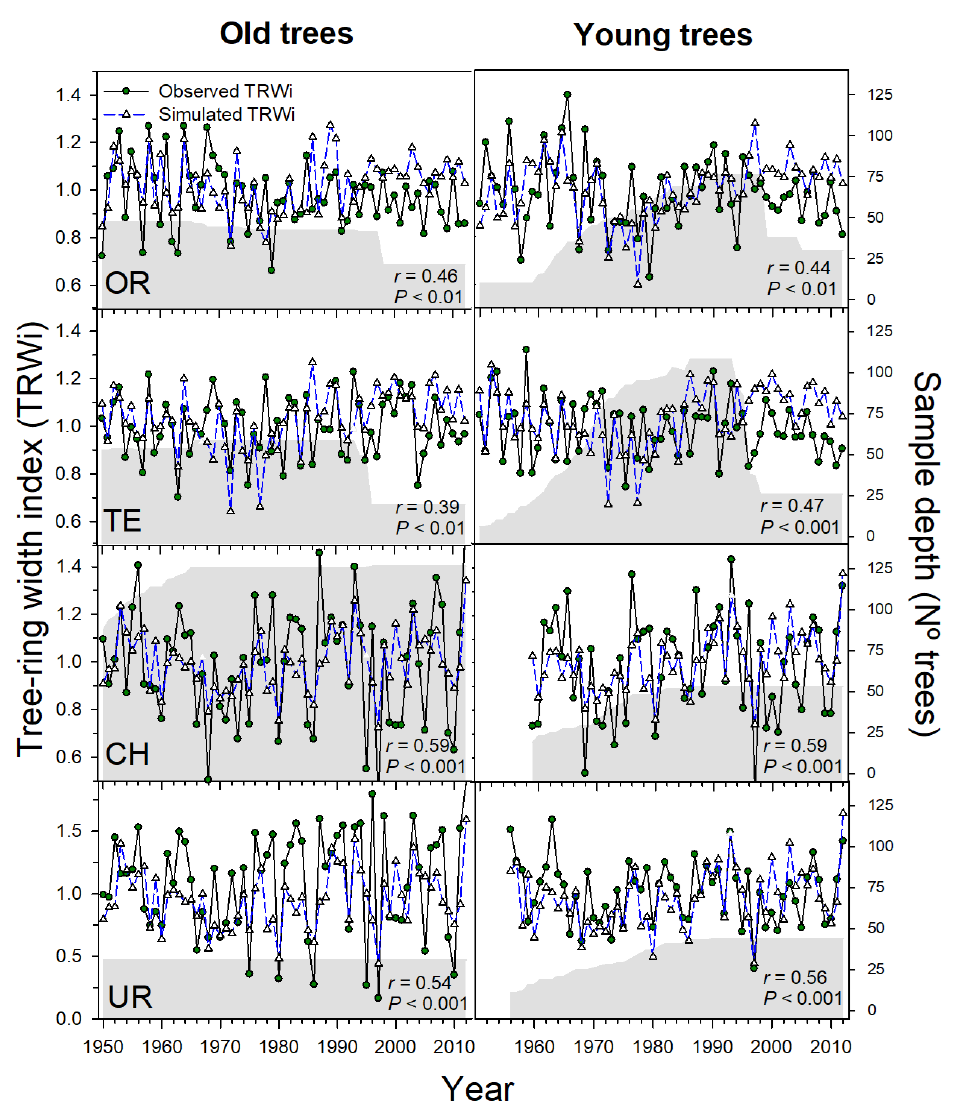
Figure 4. Observed (TRWi) and VS-Lite simulated ring-width chronologies (TRWi VSL ) for each study site and age group in the four study treeline sites. Grey areas show the number of measured trees for each site. Sites’ codes are as in Table 1.